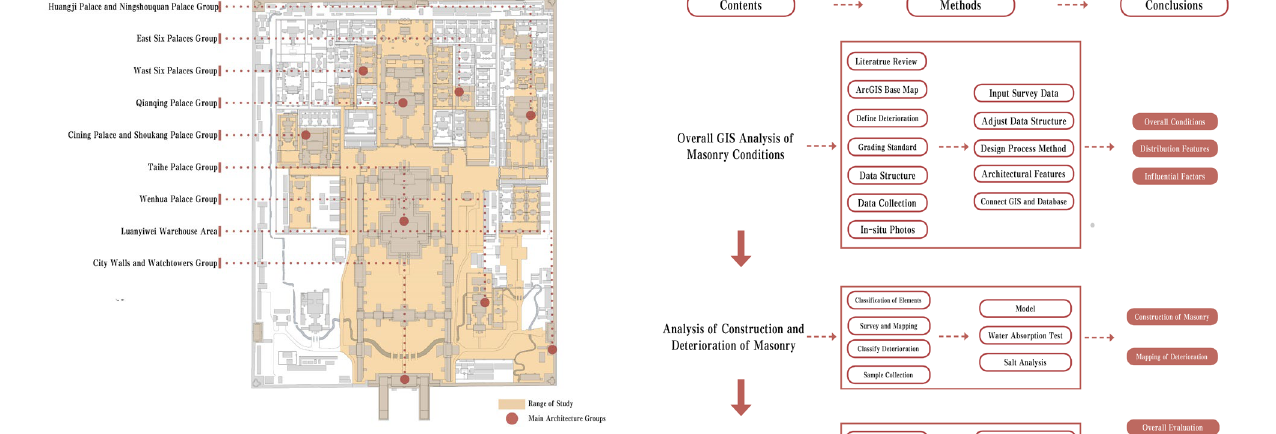
Figure 3. Main architecture groups, divided to better conduct the field survey.